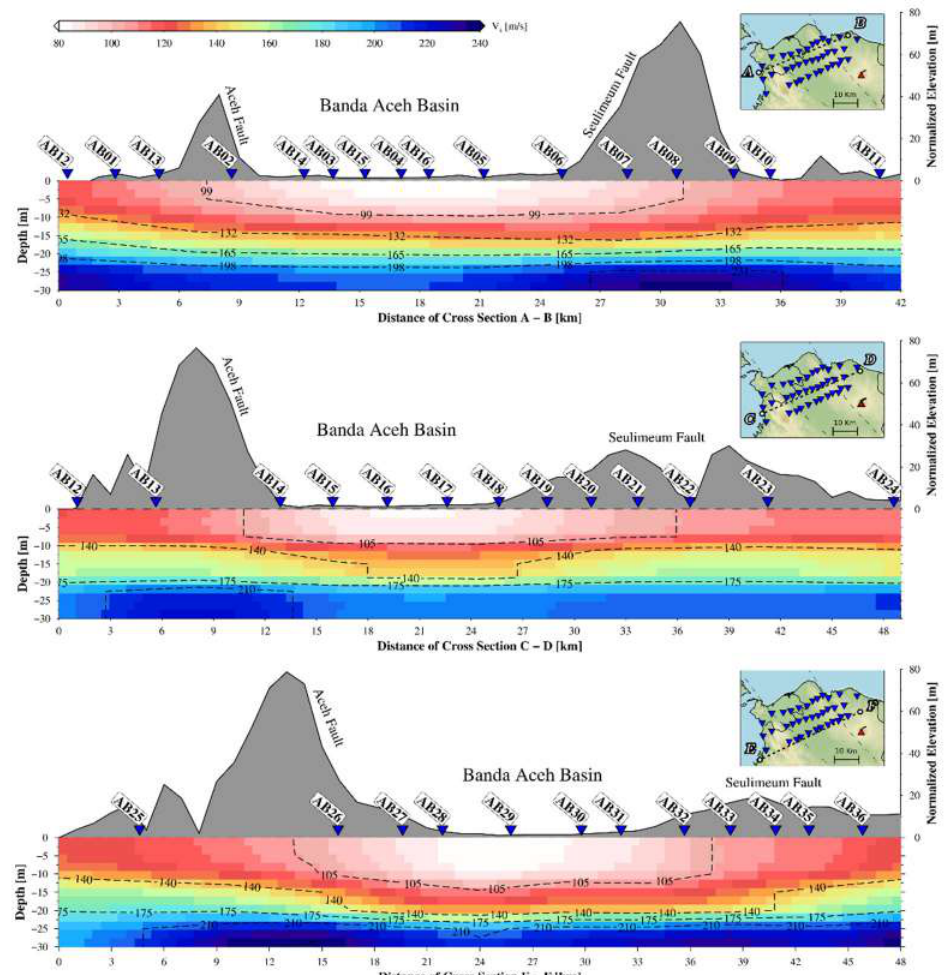
Fig. 4: Three slices are set up to figure the vertical profile of Vs over depth along lines (a) A–B, (b) C-D, and (c) E-F, respectively. The vertical profiles clearly show the existence of the Banda Aceh basin that stand on alluvial sediment in the central part, while the Aceh and Seulimeum fault stand on limestone and volcanic structure in the left and right part Table 1 : Five clusters classified from different geophysical parameters (the geological map is considered to define the possible types of rocks) Cluster Amplification (A)